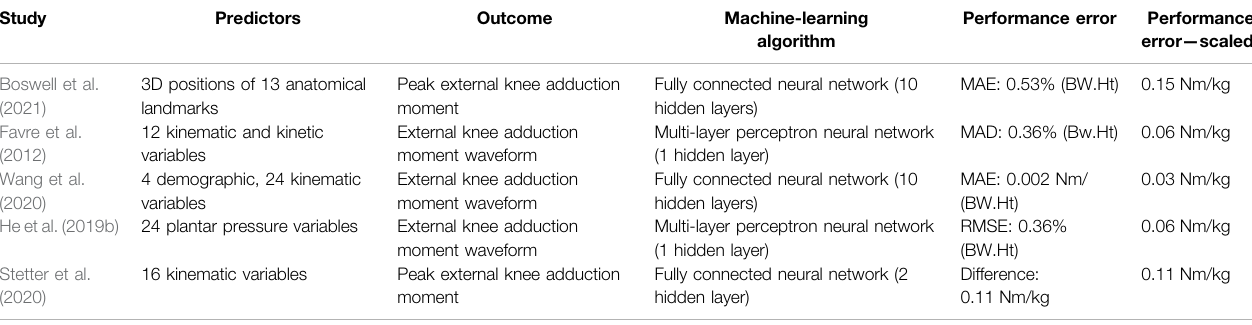
TABLE 1 | Non-exhaustive list of studies using macine learning to predicting knee